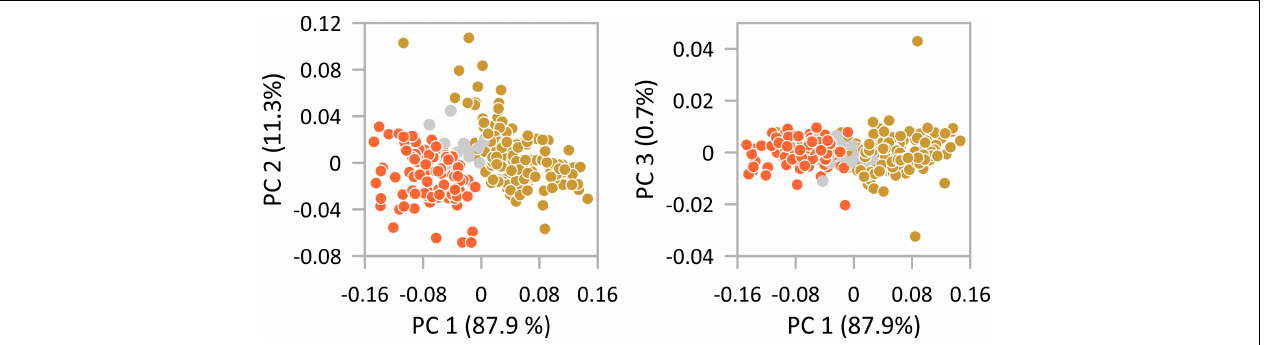
FIGURE 3 | Principal component analysis of the variability of size traits (length, height, width) of females left valves of Cyprideis torosa . Indicated is the small morphotype I (orange) and the larger morphotype II (gold). Valves of Hersek lagoon (HK) where both morphotypes co-occur are highlighted in gray.